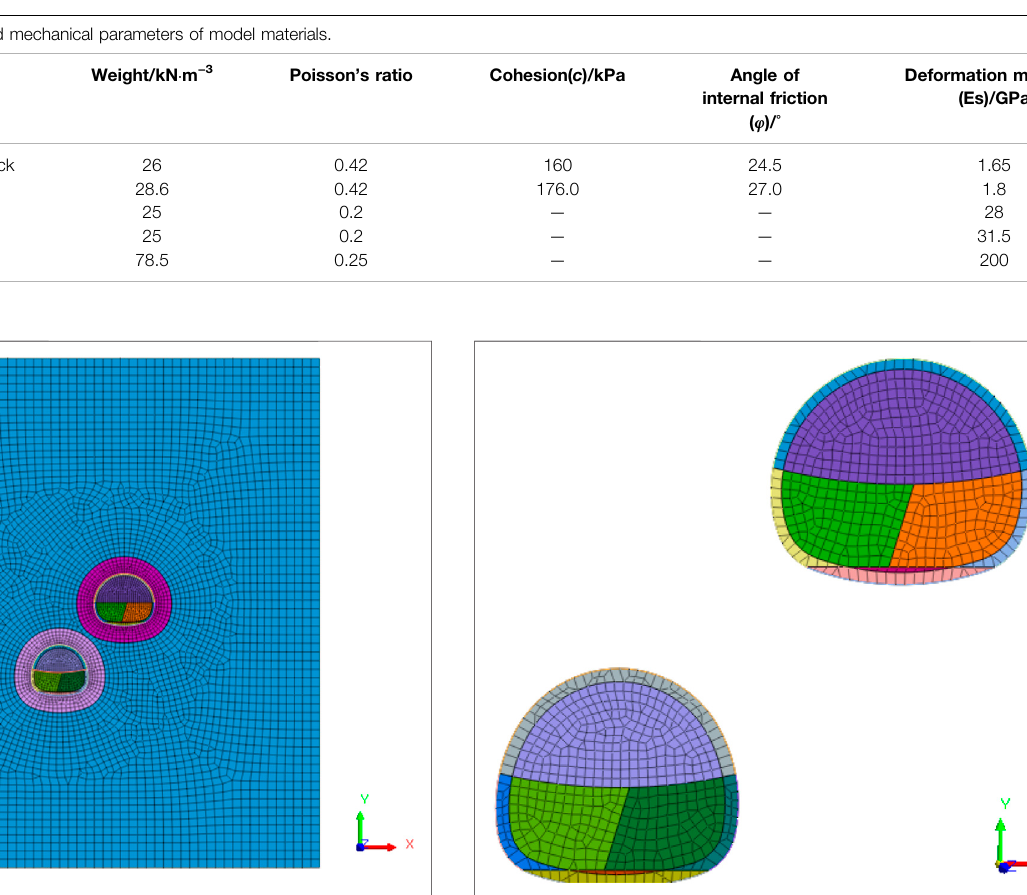
FIGURE 5 | Two-dimensional fi nite element calculation model.